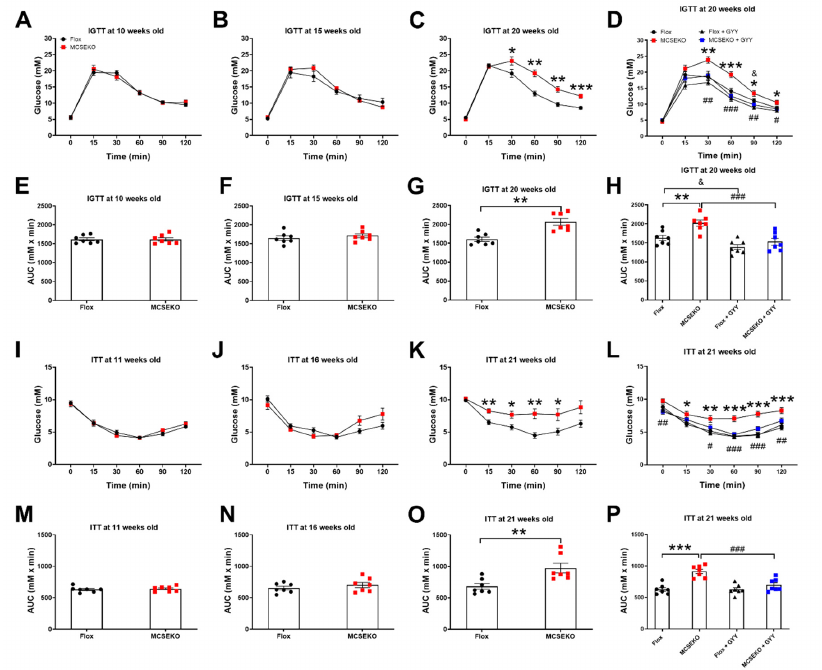
Figure 4. Glucose tolerance and insulin sensitivity are impaired in MCSEKO mice and GYY4137 treatment improves them. The mice were housed under standard conditions. The glucose tolerance tests in Flox mice and the MCSEKO mice at the age of 10 ( A , E ), 15 ( B , F ), and 20 ( C , G ) weeks, respec- tively ( n = 7 in each group). The insulin tolerance tests in Flox mice and the MCSEKO mice at the age of 11 ( I , M ), 16 ( J , N ), and 21 ( K , O ) weeks, respectively ( n = 7 in each group). Some mice at 14 weeks old were treated with GYY4137 for six weeks. ( D , H ) the glucose tolerance tests were per- formed at the age of 20 weeks ( n = 7 in each group). ( L , P ) the insulin tolerance tests were performed at the age of 21 weeks ( n = 7 in each group). Data were expressed as means ± SEM. * p < 0.05, ** p < 0.01, *** p < 0.001 (MCSEKO vs. Flox). # p < 0.05, ## p < 0.01, ### p < 0.001 (MCSEKO +GYY vs. MCSEKO). & p < 0.05 (MCSEKO +GYY vs. MCSEKO). GYY, GYY4137. 3.4. The Insulin Signal Pathway and GLUT4 Protein Level Are Down-Regulated in the Skeletal Muscle of the MCSEKO Mice and GYY4137 Treatment Ameliorates Them In skeletal muscle cells, insulin promotes glucose uptake by binding to insulin recep- tors and subsequently activating a series of signal events triggered by IRS 1 phosphoryla- tion. PI3K signaling interacts with p-IRS via p85 subunit, subsequently leads to Akt phos- phorylated. This reaction leads to membrane translocation of GLUT4, thereby promoting glucose uptake [12]. It was found that the p-IRS1/IRS1, p-PI3K/PI3K, and p-Akt/Akt were down-regulated in MCSEKO mice compared to the littermate control mice (Figure 5). Six- week GYY4137 treatment increased p-IRS1/IRS1, p-PI3K/PI3K, and p-Akt/Akt levels com- pared with vehicle treatment in MCSEKO mice. The predominant transporter for glucose uptake is GLUT4 in skeletal muscle. It was found that the GLUT4 expression was significantly decreased in the skeletal muscle of the MCSEKO mice compared to the littermate control mice (Figure 5). With six-weeks